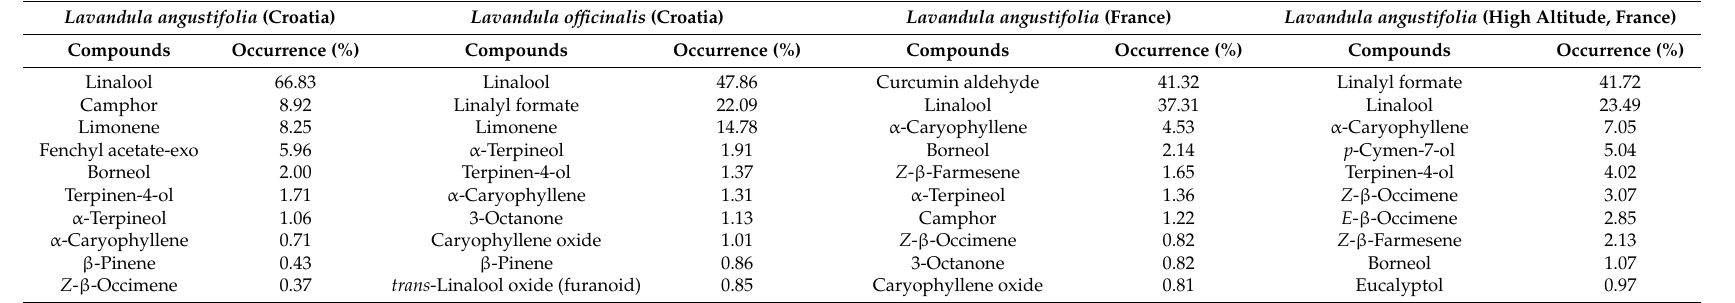
Table 3. Chemical composition (% of compound) of the Lavandula species